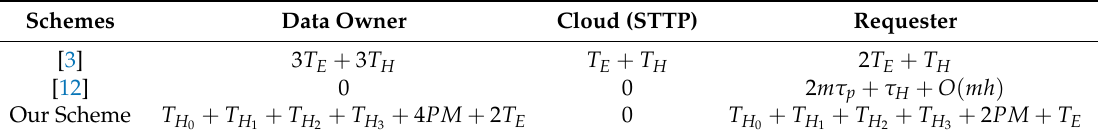
Table 5. Comparison of Computational Complexity in the Data Share